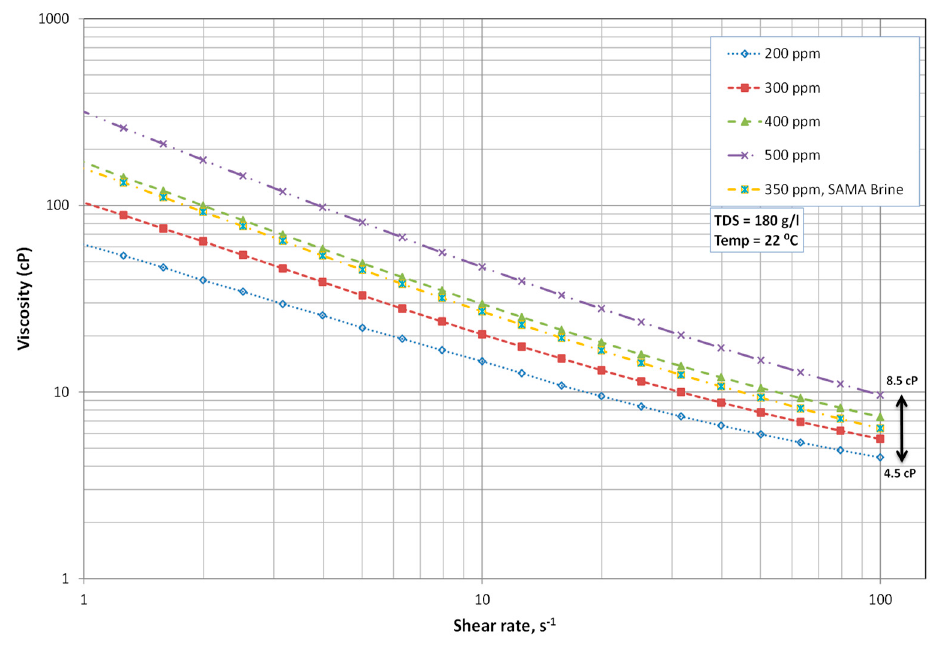
Figure 2. Effect of varying the molar concentration on the biopolymer solution viscosity for the screening experiments and the target sample: The Sabriya-Maudud (SAMA) reservoir.